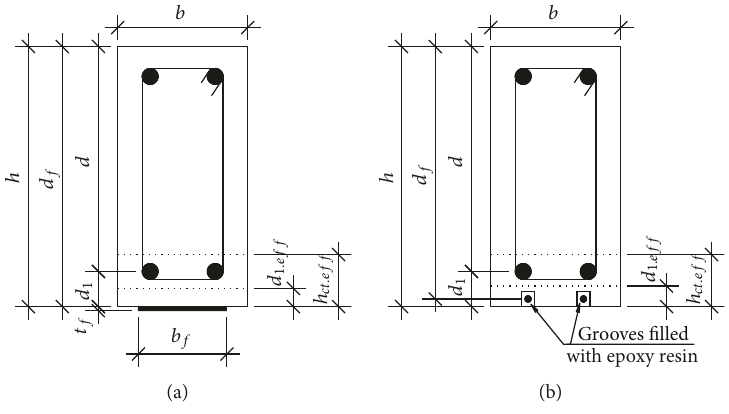
Figure 2: E ff ective tension area: (a) EBR; (b)